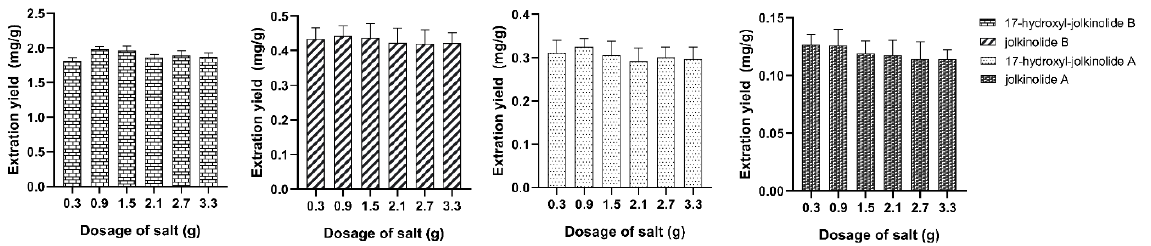
Figure 5. The effect of dosage of salt.